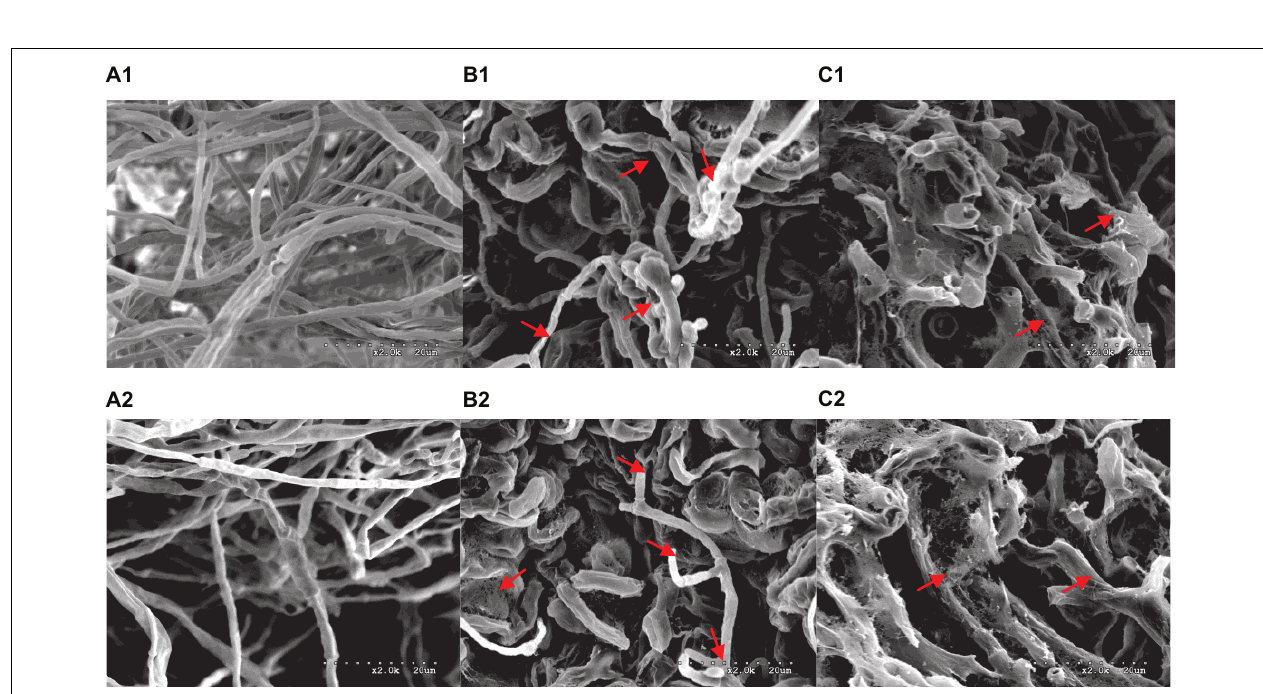
FIGURE 2 | Morphological changes of G. graminis var. tritici hyphae treated with fengycin and iturin A observed using scanning electron microscopy (SEM). (A 1 ,A 2 ) The untreated Ggt hyphae; (B 1 ,B 2 ) the Ggt hyphae treated with fengycin, showing dehydration, entanglement, irregular expansion, and ring formation; (C 1 ,C 2 ) the Ggt hyphae treated with iturin A, showing cell membrane digestion and hyphal rupture.